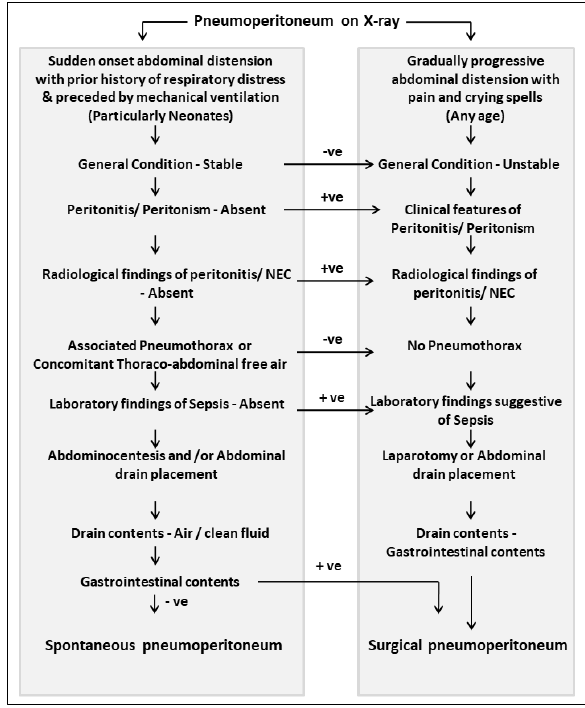
Figure 6: Algorithm for the